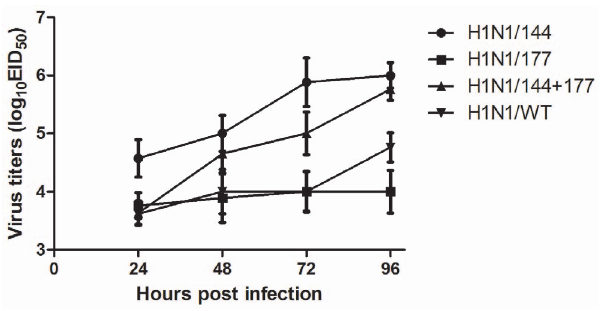
Figure 2. Virus elution from erythrocytes. Two-fold dilutions of virus containing the HA titers of 1:32 (2 5 ) were incubated with equal volume of 0.5% chicken erythrocytes in microtiter plates at 4 u C for 1 h. The microtiter plates were then stored at 37 u C, and the reduction of HA titers was recorded periodically for 240 min.